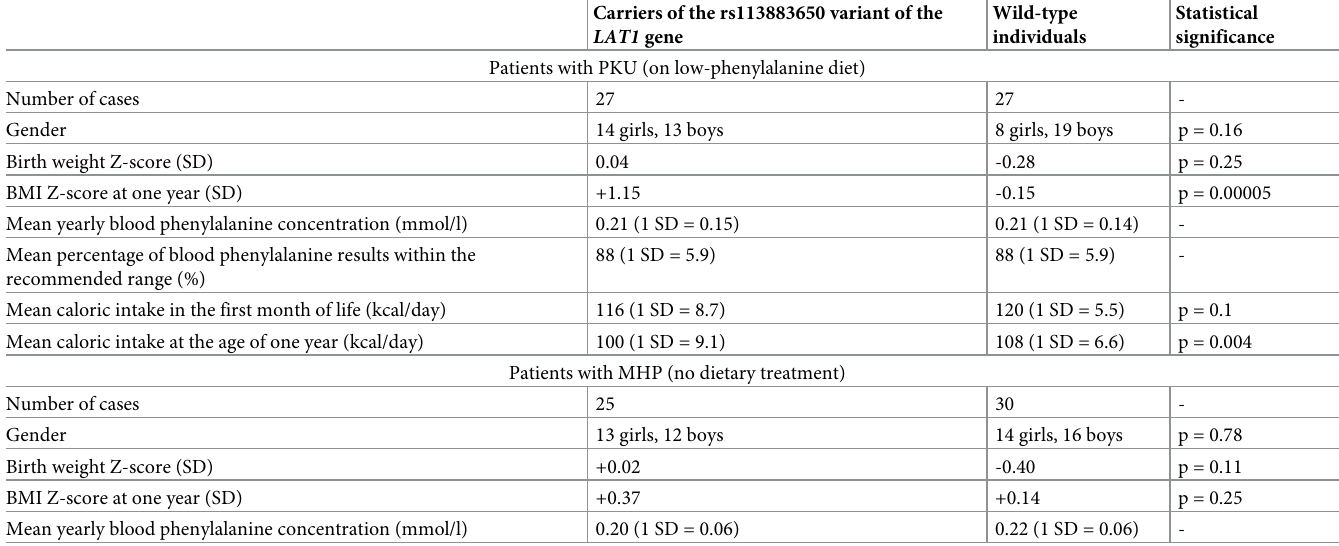
Table 1. Comparison of carriers of the rs113883650 variant of the LAT1 gene and wild-type individuals in patients with PKU and MHP. Carriers of the rs113883650 variant of